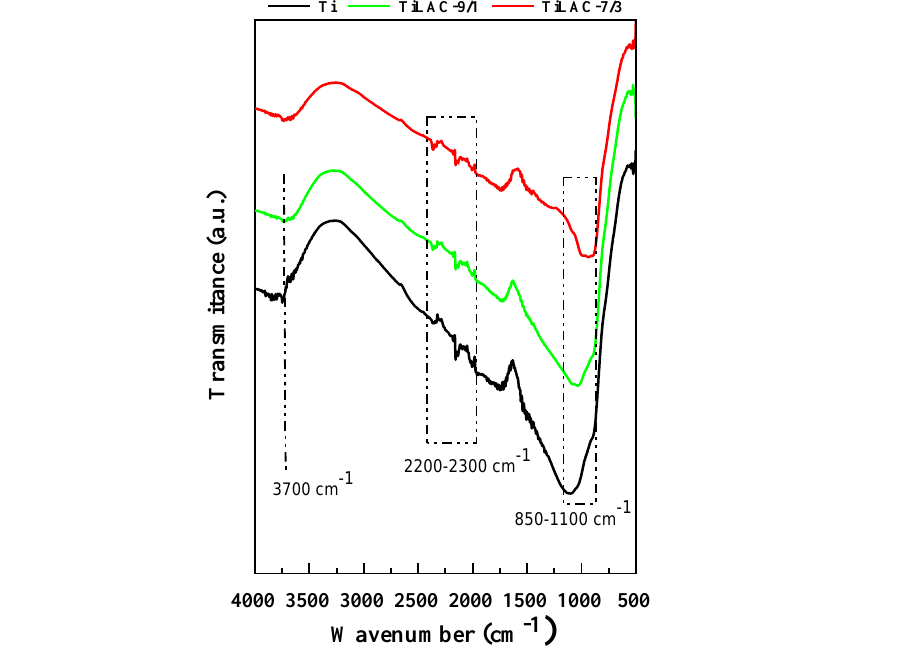
Figure 5. FTIR spectra for Ti, TiLAC-7/3, and TiLAC-9/1 samples.